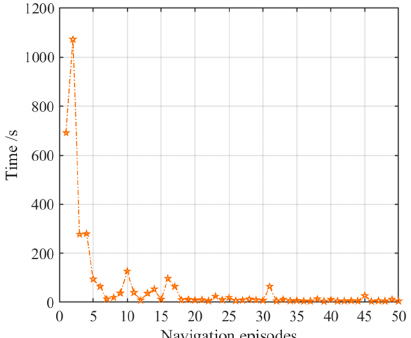
Figure 20. Navigation time with the striatal model alone when door B is closed. Orange pentagrams indicate the navigation time for each navigation episode.